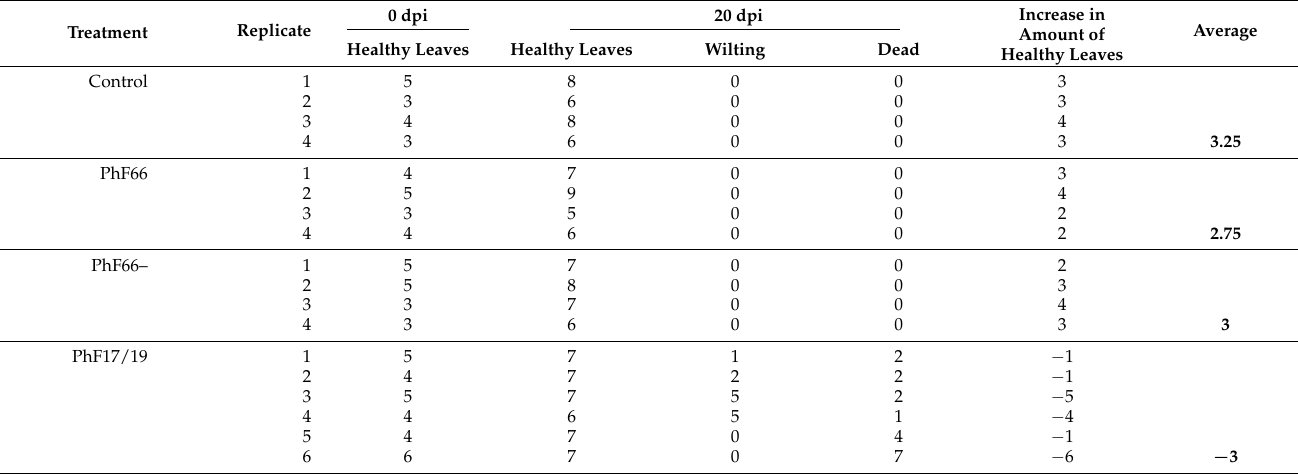
Figure 3. Mean lesion lengths from Phytophthora cactorum pathogenicity test on silver birch at 13 dpi. Error bars: 95% CI.